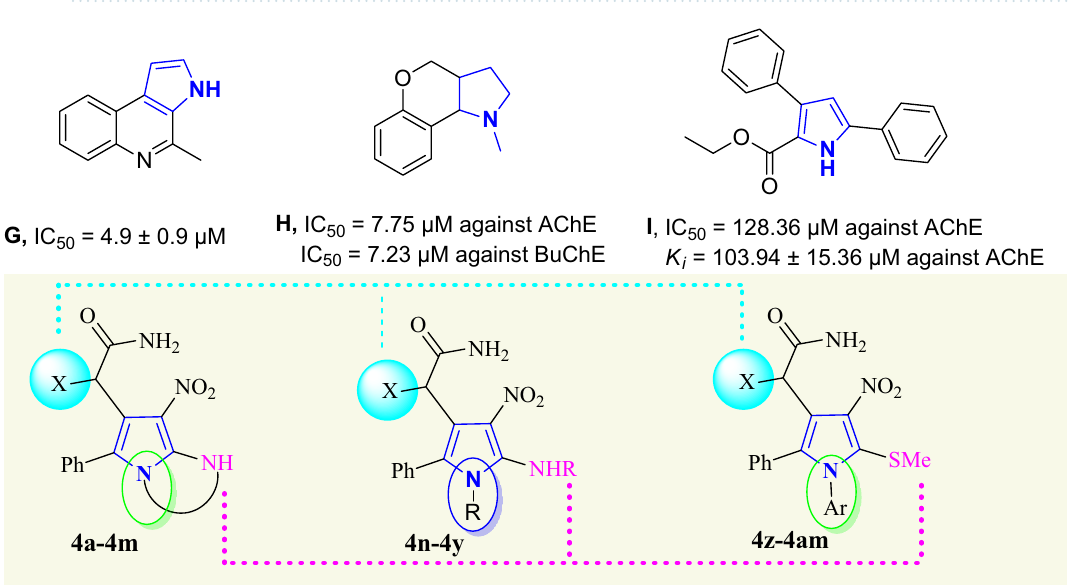
Figure 3. Structures of previously studied pyrrole derivatives as ChE inhibitors and the newly designed compounds ( 4a-m , 4n-y, and 4z-am)